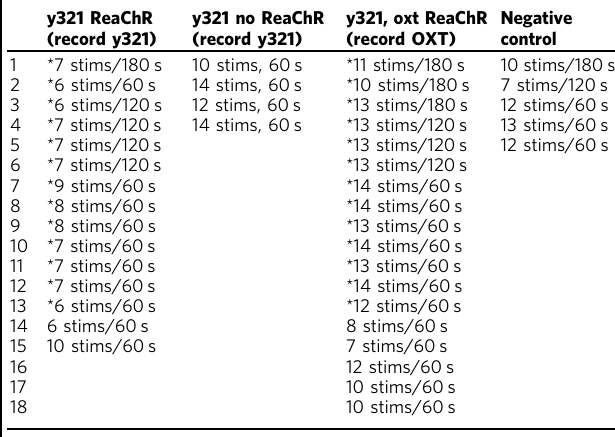
Table 1 Summary of optogenetic experiments